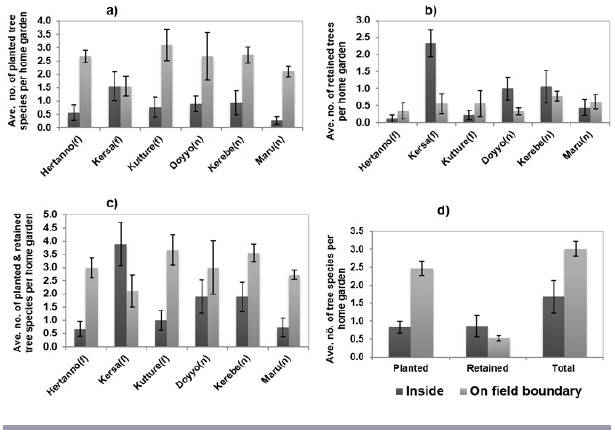
Fig. 4 . Average numbers of tree species, recorded inside and along boundaries of home gardens for: (a) planted, (b) retained, (c) planted and retained pooled for individual villages, and (d) pooled data from all villages. The statistical interpretations of the patterns are found in the text. Error bars are standard error. The sample size is found in Table 2.